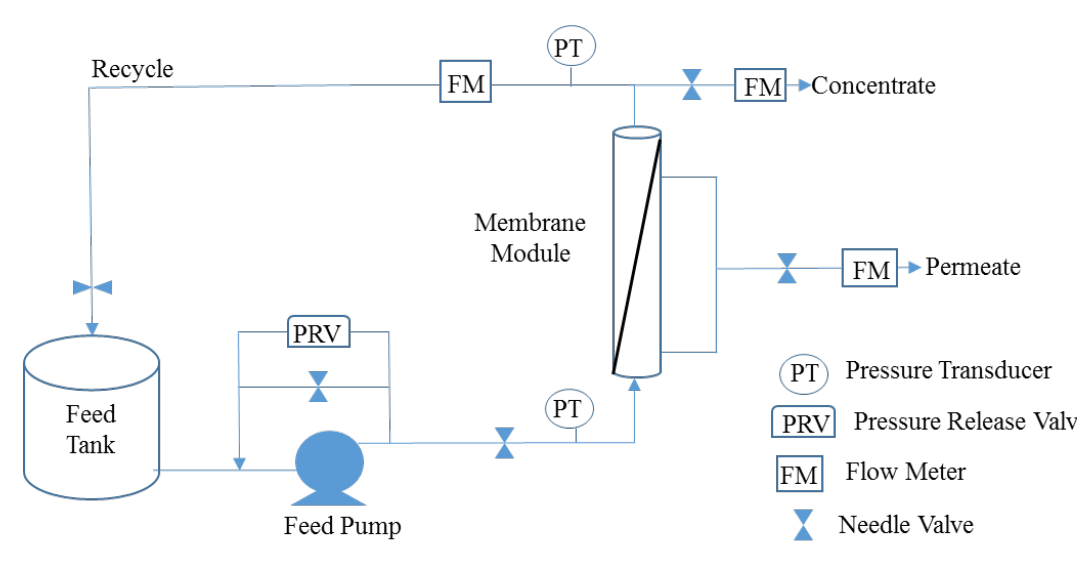
Figure 1. Process flow diagram of membrane testing equipment.